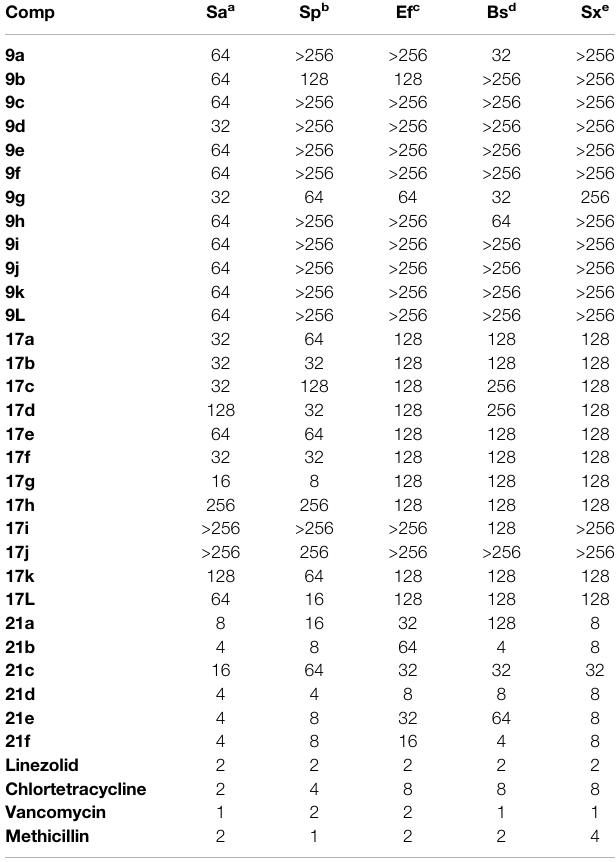
TABLE 1 | MICs ( μ g/ml) of compounds 9a-l , 17a-l and 21a-f against fi ve Gram- positive